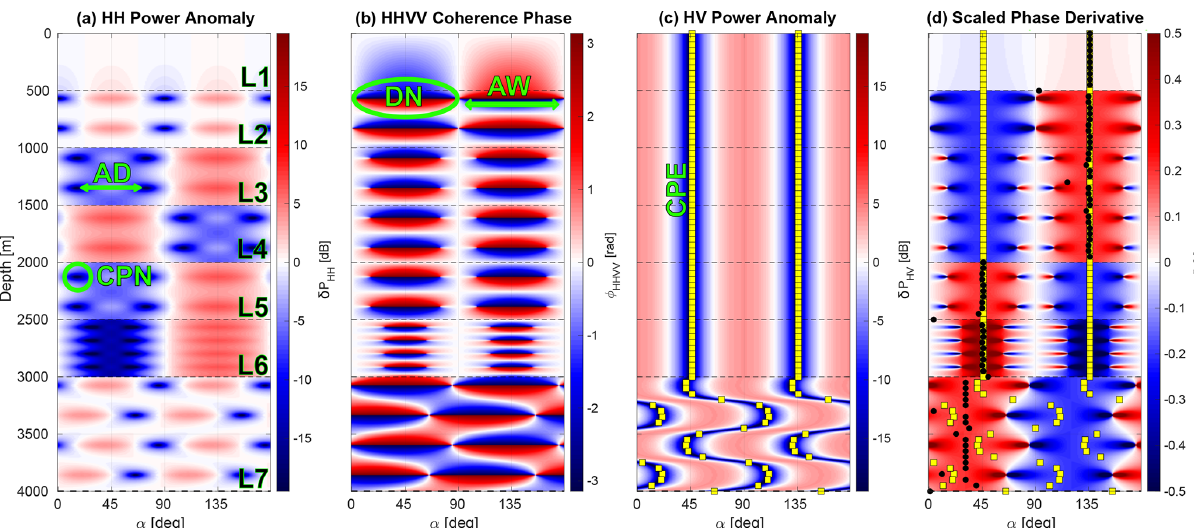
Figure 3. A seven-layer synthetic model generated by Eq. (5) using the model parameters in Table 2. Horizontal dashed black lines are the layer boundaries with layer numbers from L1 to L7. (a) HH power anomaly ( δP HH ) representing co-polarization node (CPN) and node angular distance (AD). (b) HHVV coherence phase ( φ HHVV ) displaying dipole co-polarized node (DN) and node angular width (AW). (c) HV power anomaly ( δP HV ) representing cross-polarization extinction (CPE). (d) Scaled phase gradient ( (cid:57) ) displaying the direction of v 1 (yellow squares in blue areas) and v 2 (yellow squares in red areas). The magnitude of (cid:57) at the black dots is the value of horizontal anisotropy ( (cid:49)λ ).